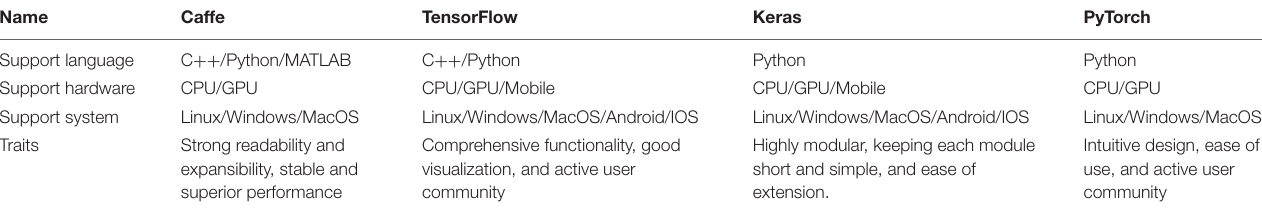
TABLE 3 | Comparison of Caffe, TensorFlow, Keras, and PyTorch.